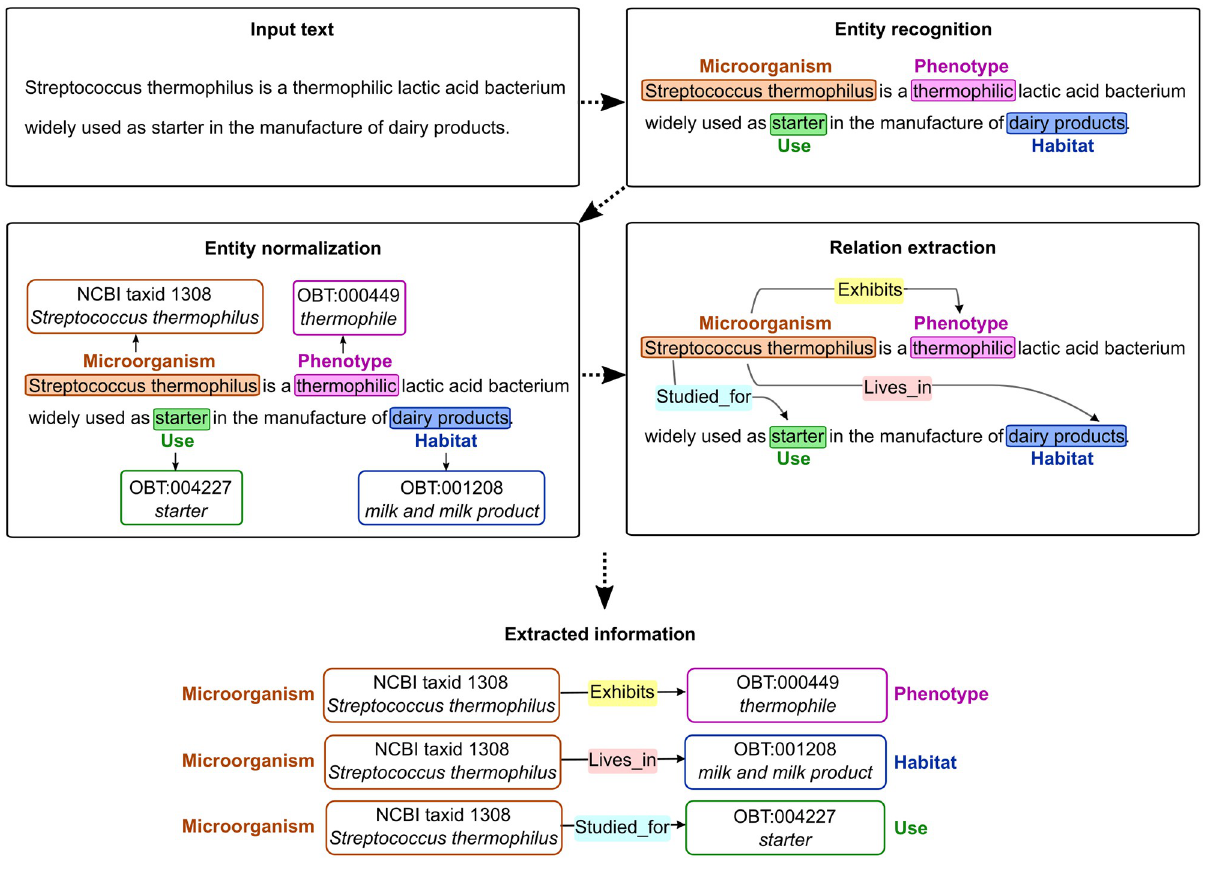
Fig 1. Text-mining